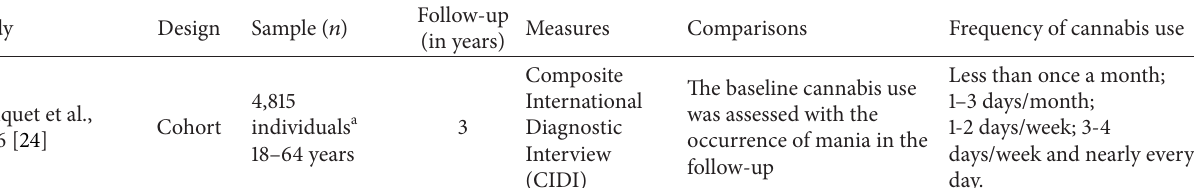
Table 3: Frequency of use of cannabis in bipolar